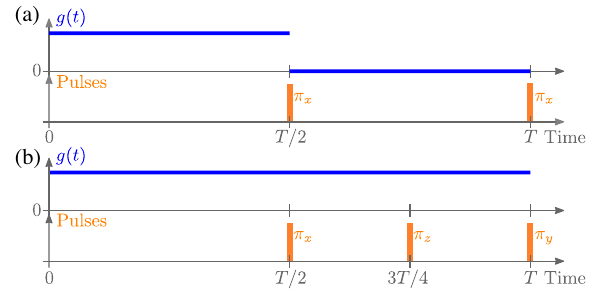
FIG. 7. Dynamical-decouping sequences to cancel inhomo- geneous broadening in Eq. (22). Each sequence has a total T ≪ 1 and κ T ≪ 1 , and is repeated duration time T , where κ sqz int multiple times. (a) A simple sequence of π pulses about the x axis ˆ Σ † will generate unwanted ð r Þ antidamping terms [cf. Eq. (23)]. Therefore, the coupling to the spins g ð t Þ must be switched off after every second π pulse. (b) By adding two additional π pulses x about the y and z axes, the detrimental impact of the first π pulse x can be canceled, and the coupling g ð t Þ can be kept